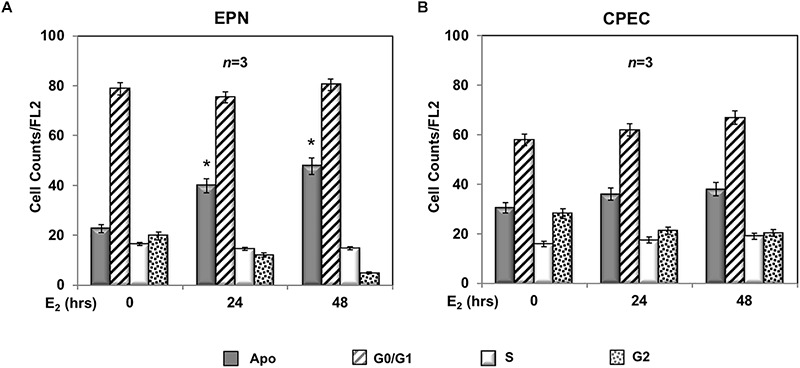
Effect of estradiol on cell cycle. Flow cytometry analysis of propidium iodide-labeled EPN (A) or CPEC (B) cells was done, as described in Methods. Quiescent cells were left under basal conditions or treated with estradiol (20 nM; E2) for the indicated times. Histograms represent the % counts/FL2 areas of labeled cells in the different cell cycle phases after 24 or 48 h of hormonal treatment. Means and SEMs are shown. n represents the number of experiments. ∗p < 0,05 for each experimental point vs. the corresponding untreated control.